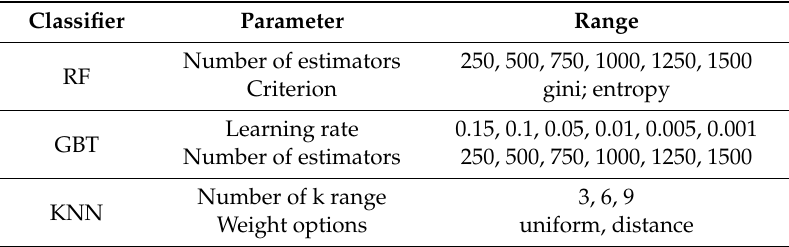
Table 1. Range of parameters for classification